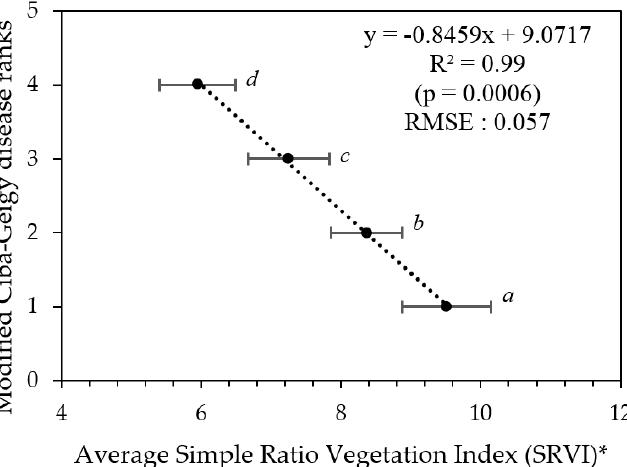
Figure 8. Modified Ciba-Geigy disease ranks as a function of average SRVI (trees grouped according to their modified Ciba-Geigy disease ranks in Table 5). * Error bars indicate the confidence limits for each rank. Means with similar letters are not significantly different from each other at p > 0.05.